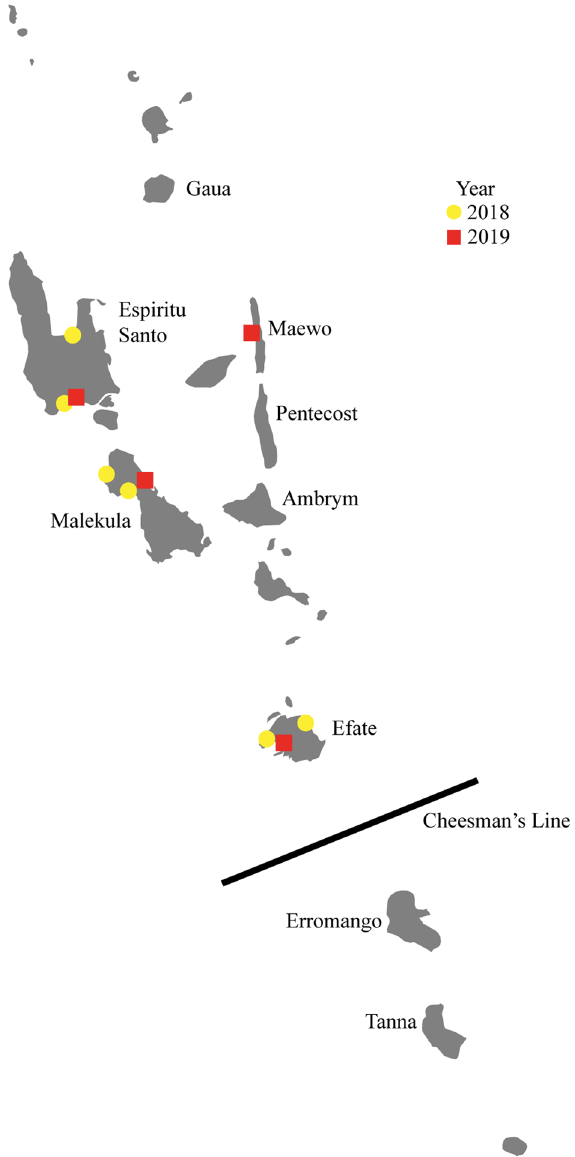
Figure 1. Distribution map showing occurrence data for Atyphella across Vanuatu based on field expeditions in 2018 and new locations from 2019. The islands explored over both years are labeled. Black line denotes the biogeographic break known as Cheesman’s Line (Vemaps.com, Adobe, San Jose, CA,